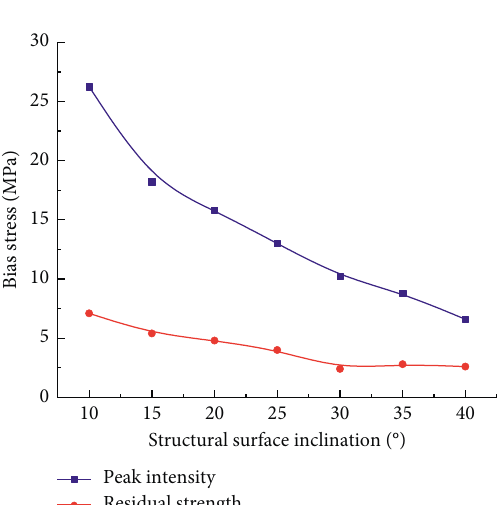
Figure 3: Test specimens.